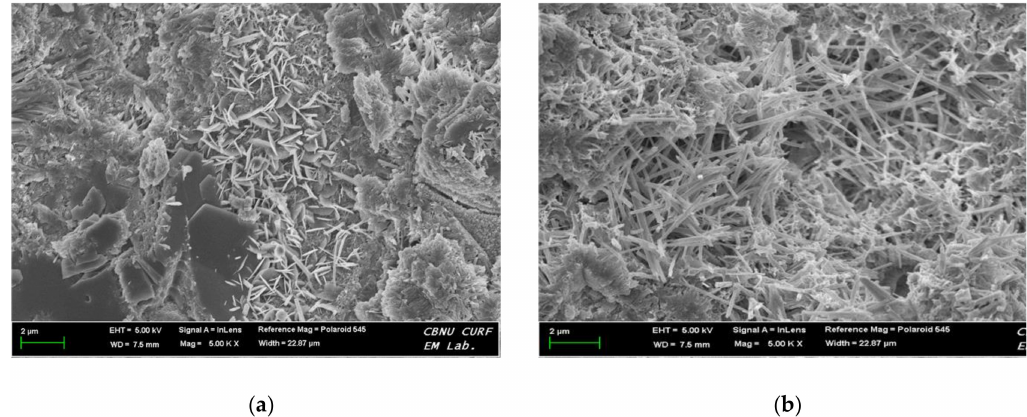
Figure 9. Scanning electron microscope images: ( a ) OPC, ( b ) AAC at 7 days (5000 × magnification).